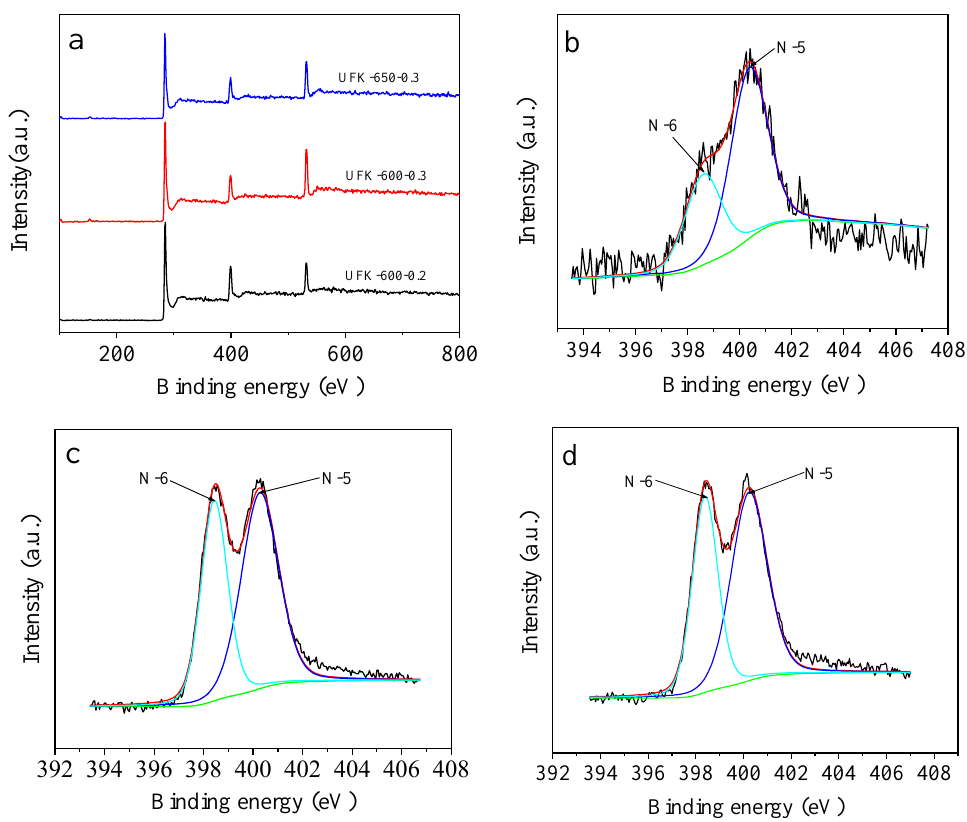
Figure 2. XPS survey ( a ) of selected adsorbents, XPS N1s of ( b ) UFK-600-0.2, ( c ) UFK-600-0.3, and ( d ) UFK-650-0.3.